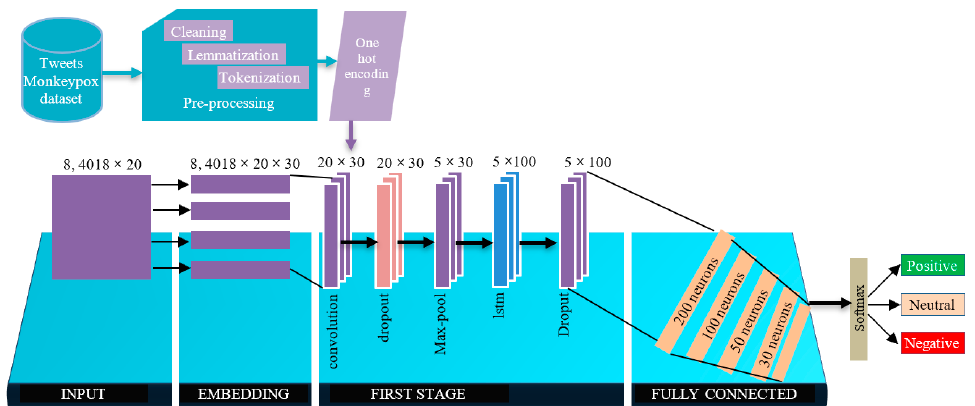
Figure 3. General sentiment classification and analysis process.